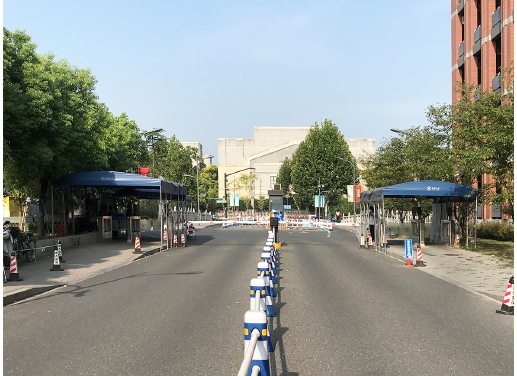
Figure A2. Gated entrance with intelligent access control facilities and 24 h campus guards (photo taken on 9 September 2022).